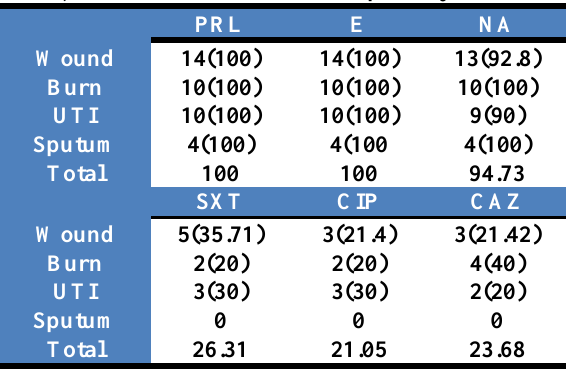
Table, 6: Showed antibiotics susceptibility